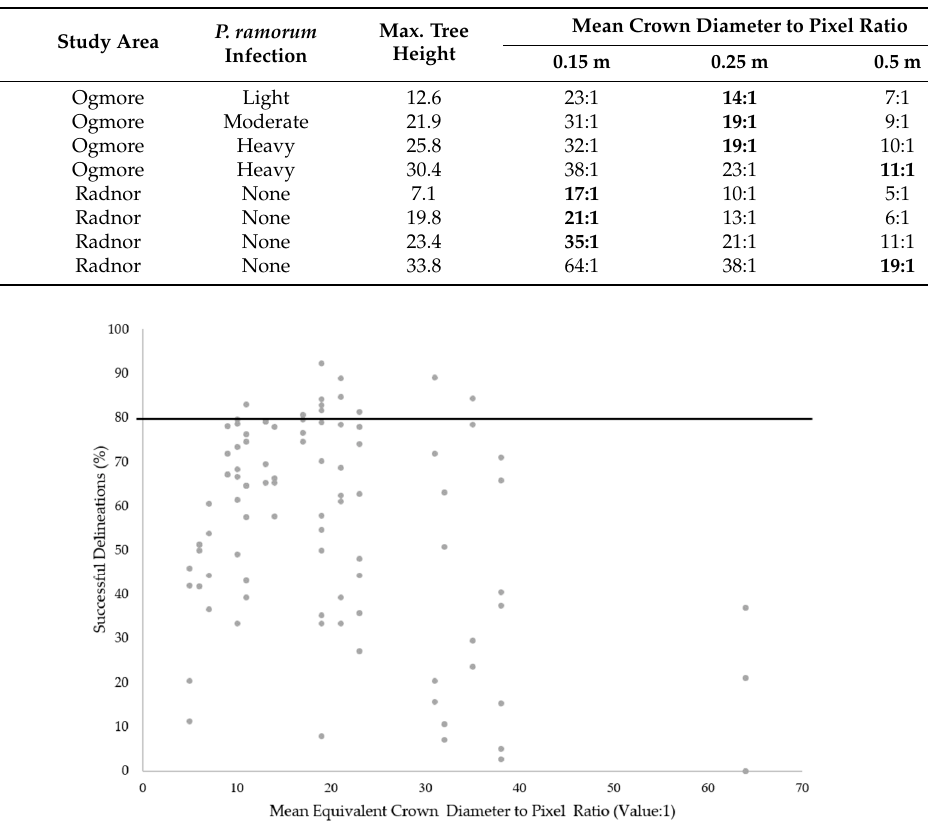
Figure 8. The relationship between mean equivalent crown diameter to pixel size ratio and successful delineation (%) for all segmentation algorithms (marker-controlled watershed and region growing), CHM generation methods (standard and pit-free) and CHM pixel sizes (0.15 m, 0.25 m, and 0.5 m). The solid black line represents the number successful delineations at 80%.